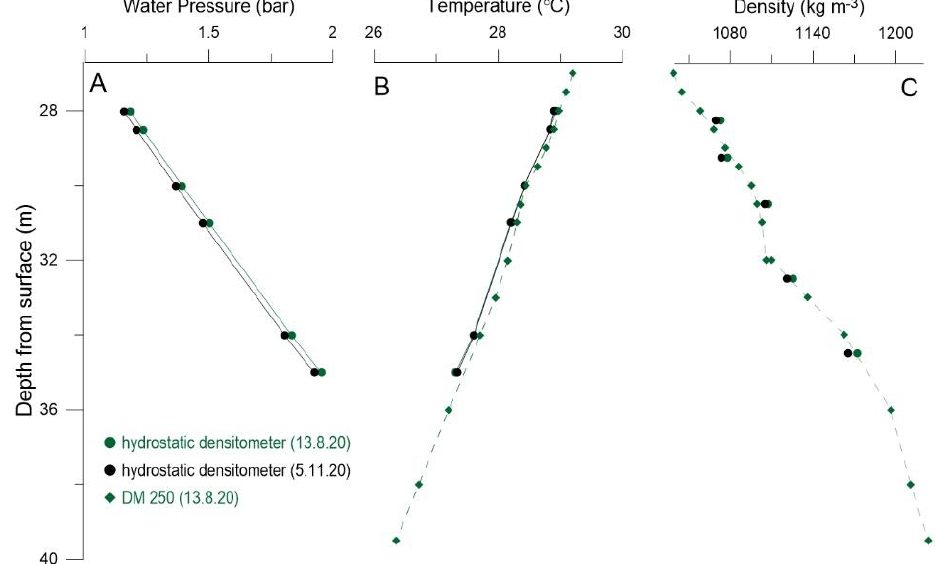
Figure 7. The borehole water profiles. Measured scalars along the borehole: ( A ) water pressure; ( B ) temperature; ( C ) density. The profiles were measured at the beginning and end of the deployment (dates in dd.mm.yy). The density profiles were measured with two independent methods: the hydrostatic densitometer and the portable density meter, showing good agreement (see